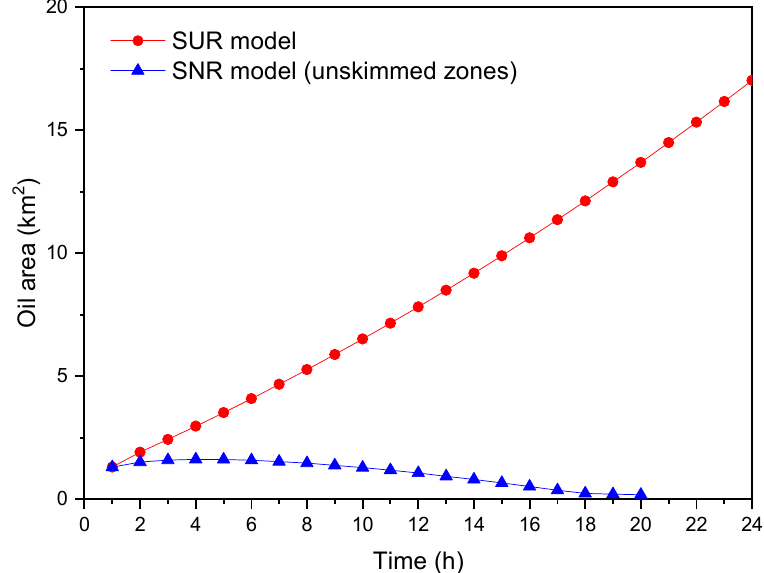
Figure 8. Comparison between the SUR model oil slick area and the unskimmed zone area of the SNR model.